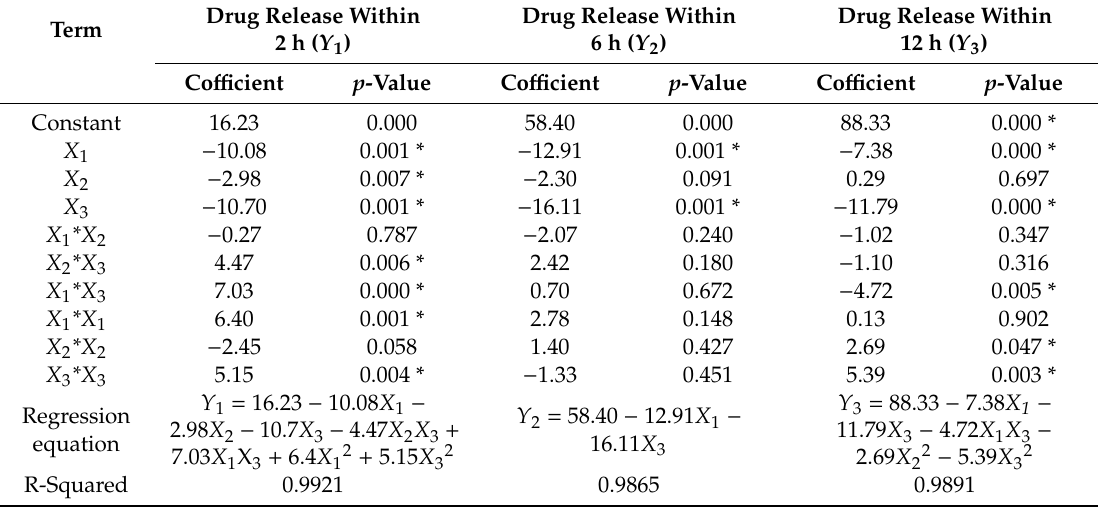
Table 4. Regression coe ffi cients and associated p -values of the fitted